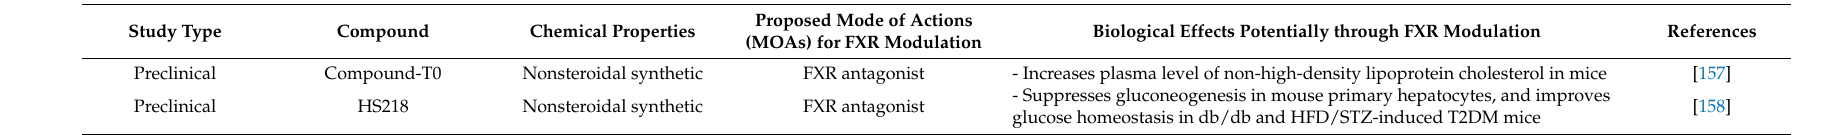
Table 2. Novel candidate compounds for FXR antagonism/inhibition. db/db—leptin receptor-deficient diabetic; HFD—high-fat diet; STZ—streptozotocin; T2DM—type 2 diabetes